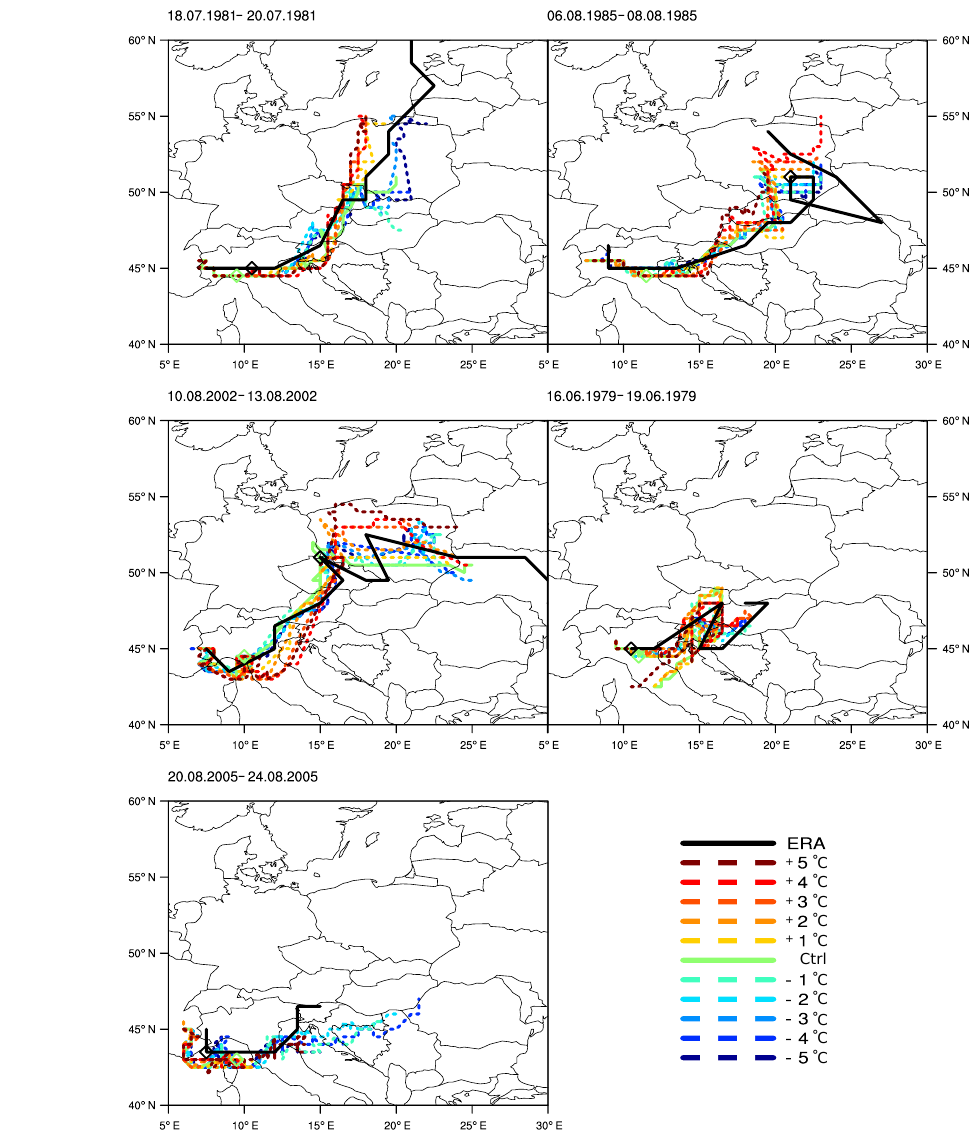
Figure 3. Tracks for the five different Vb events. The black line depicts the tracks that are obtained using the ERA-Interim data set. The light green line shows the tracks detected in the control simulation. The stippled lines show the tracks of the different Mediterranean SST experiments. The green and black diamonds represent the point of the cyclone at which it reaches the strongest gradient during its lifetime for the control simulation and ERA-Interim,